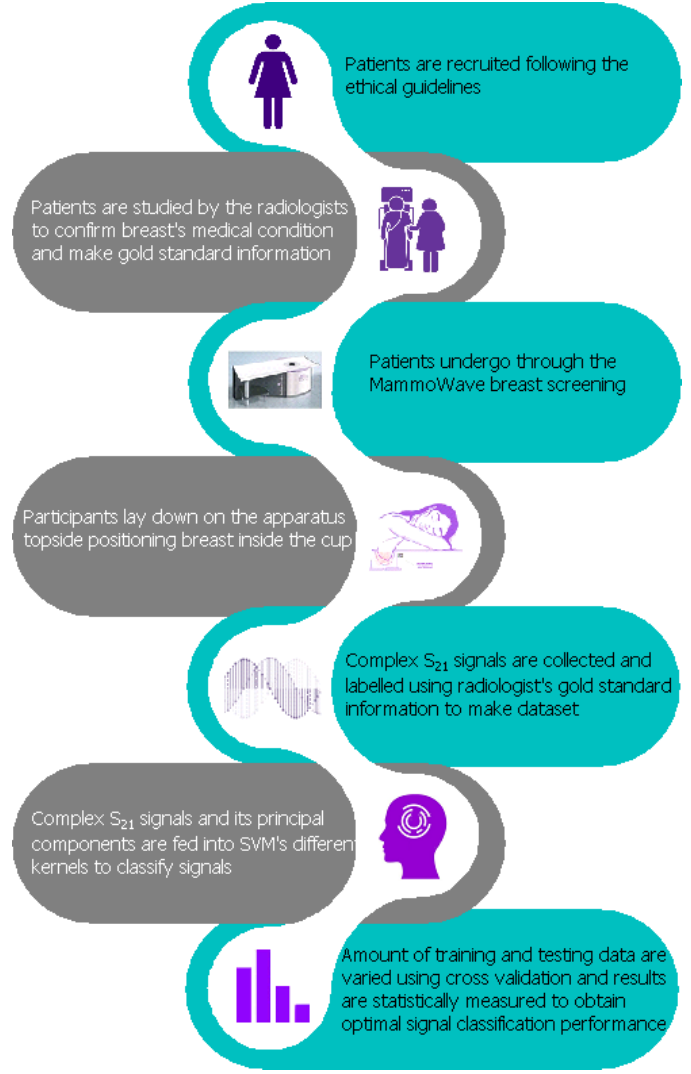
Figure 1. Proposed flow chart of MammoWave signal classification for the breast lesion